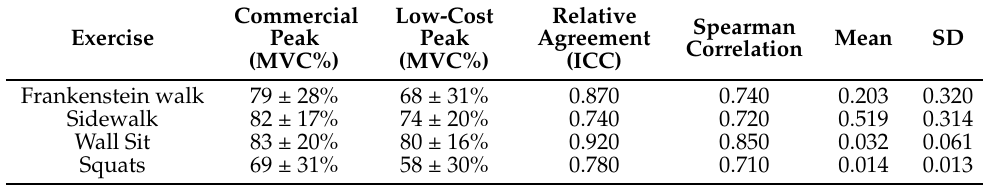
Table 3. Dynamic exercise at peak level.